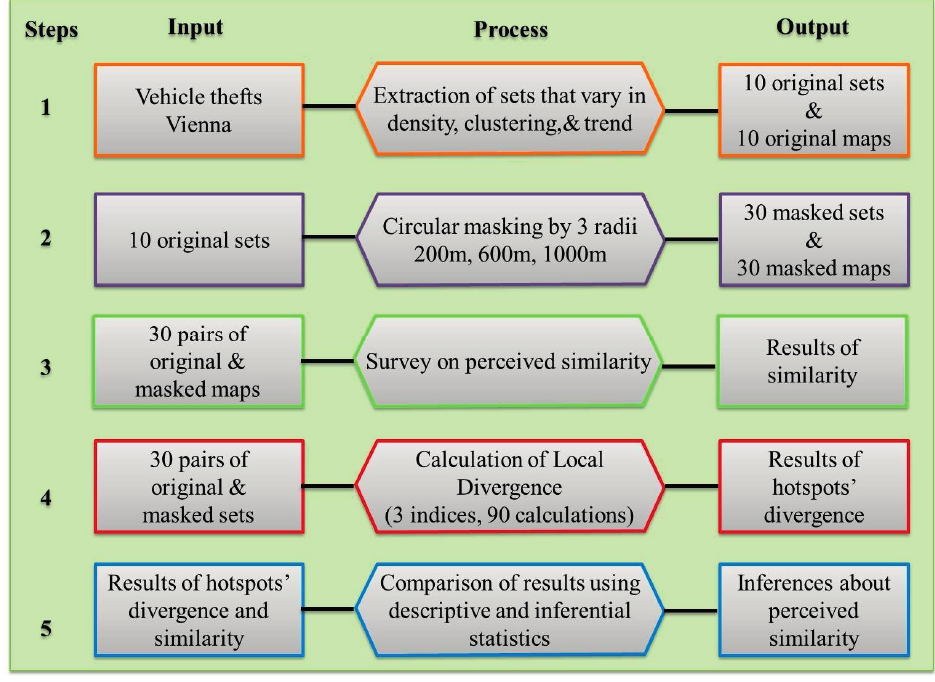
Figure 3. The analytical strategy of the